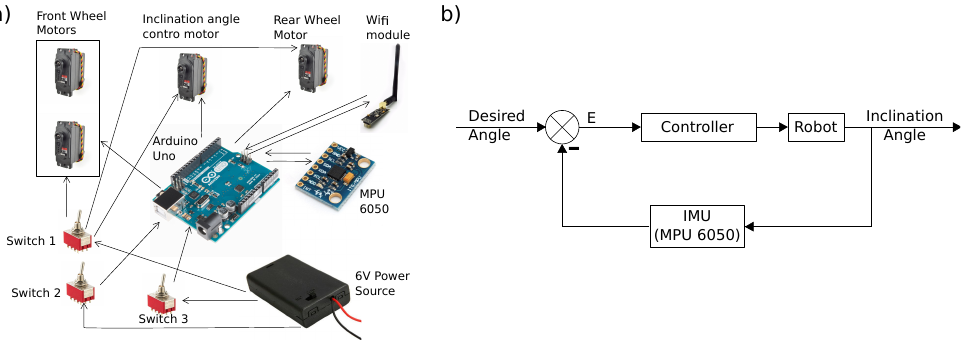
Figure 16. ( a ) Electronics components diagram; ( b ) block diagram of the